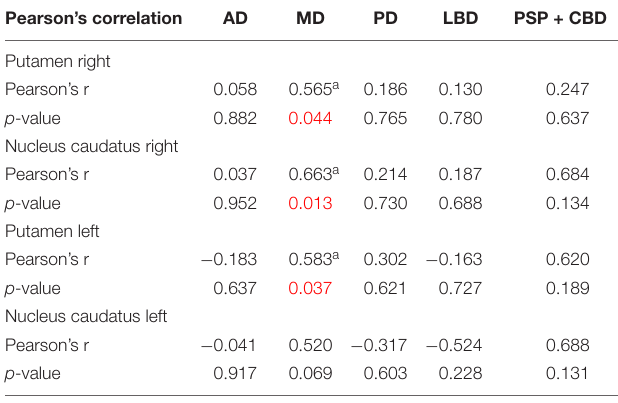
TABLE 3 | Pearson’s correlation neurofilament light chain (NfL).